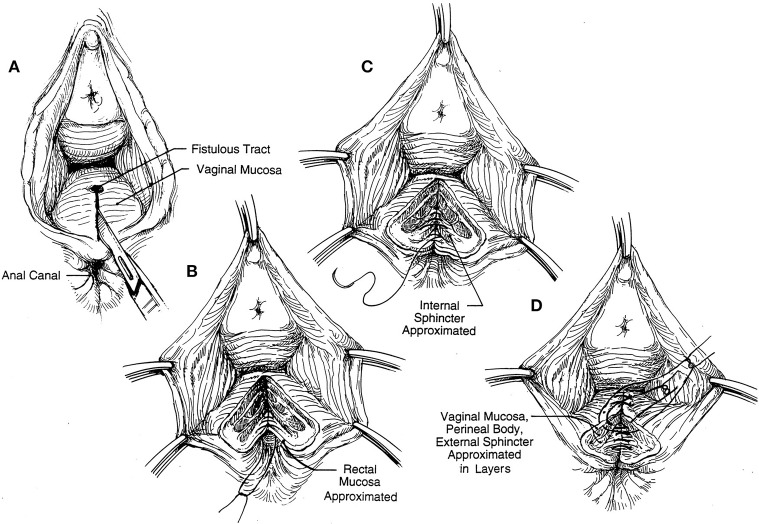
(A–D) Schematic representation of exposure for layered closure: the rectal mucous membrane and anal canal lining repaired followed by the rectal muscle and internal sphincter and the reunion of the retracted external anal sphincter infront (5) (with permission).